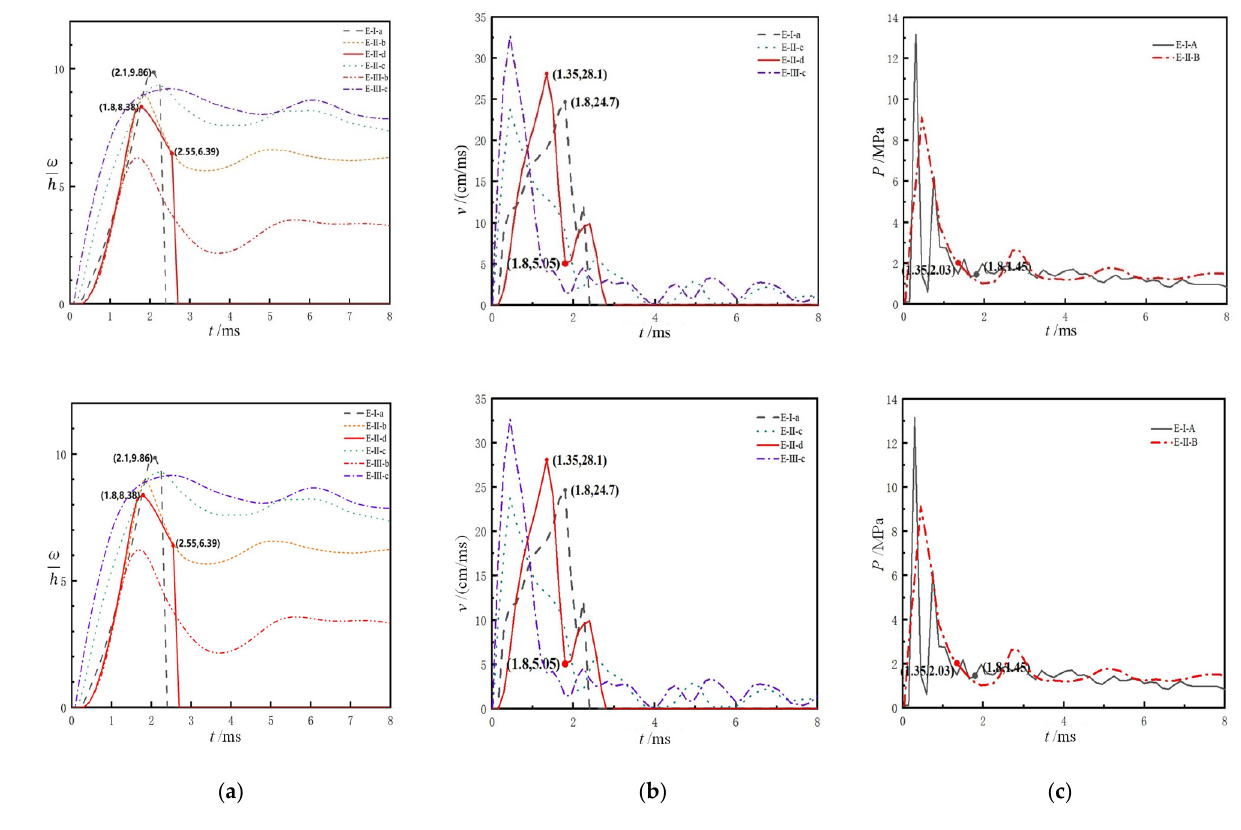
Figure 6. The variation of deflection, velocity, and pressure at different marker points. ( a ) Variation of deflection; ( b ) Variation of velocity; ( c ) Variation of pressure.